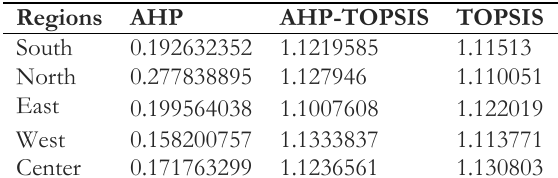
Table 11. The secondary decision matrix.